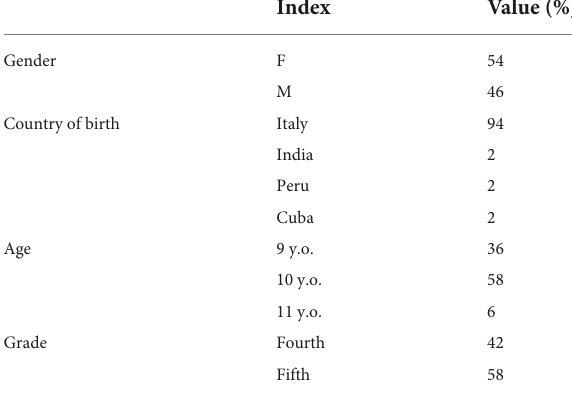
TABLE 1 Summary of data concerning the sample from the entry